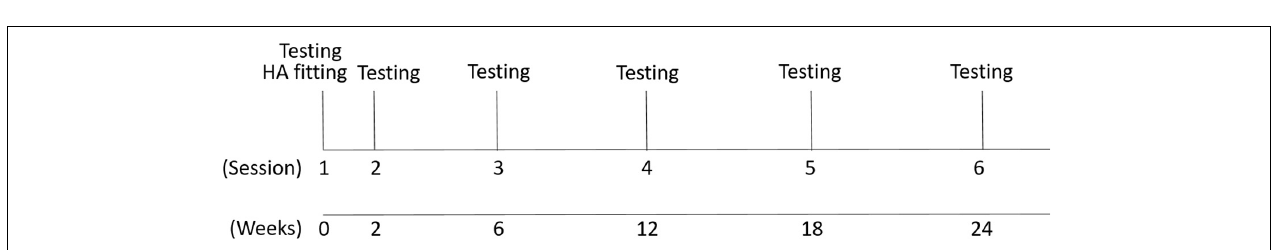
FIGURE 1 | Individual pure-tone air-conduction thresholds for participants from 125 to 8,000 Hz. The solid gray line indicates group average pure tone thresholds.